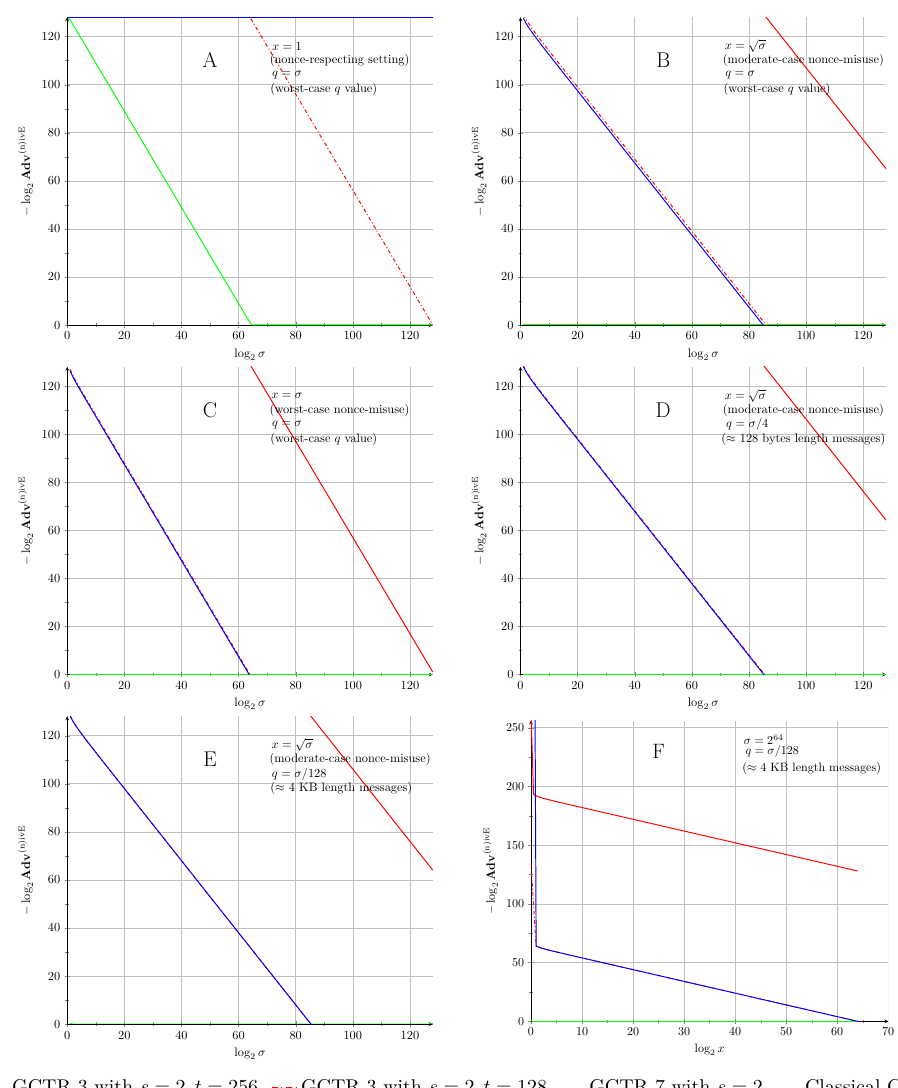
Figure 3: Security comparison (as logarithmic plots of the advantage functions) of GCTR-3 and GCTR-7 using an MFC with s = 2 with the classical CTR mode for n = 128. We plot the (n)ivE advantage of an adversary as a function of the total number of queried blocks σ (in plots A to E) and as a function of the total number of repeated nonces x (in plot F). From Fig. 3, we infer for s =